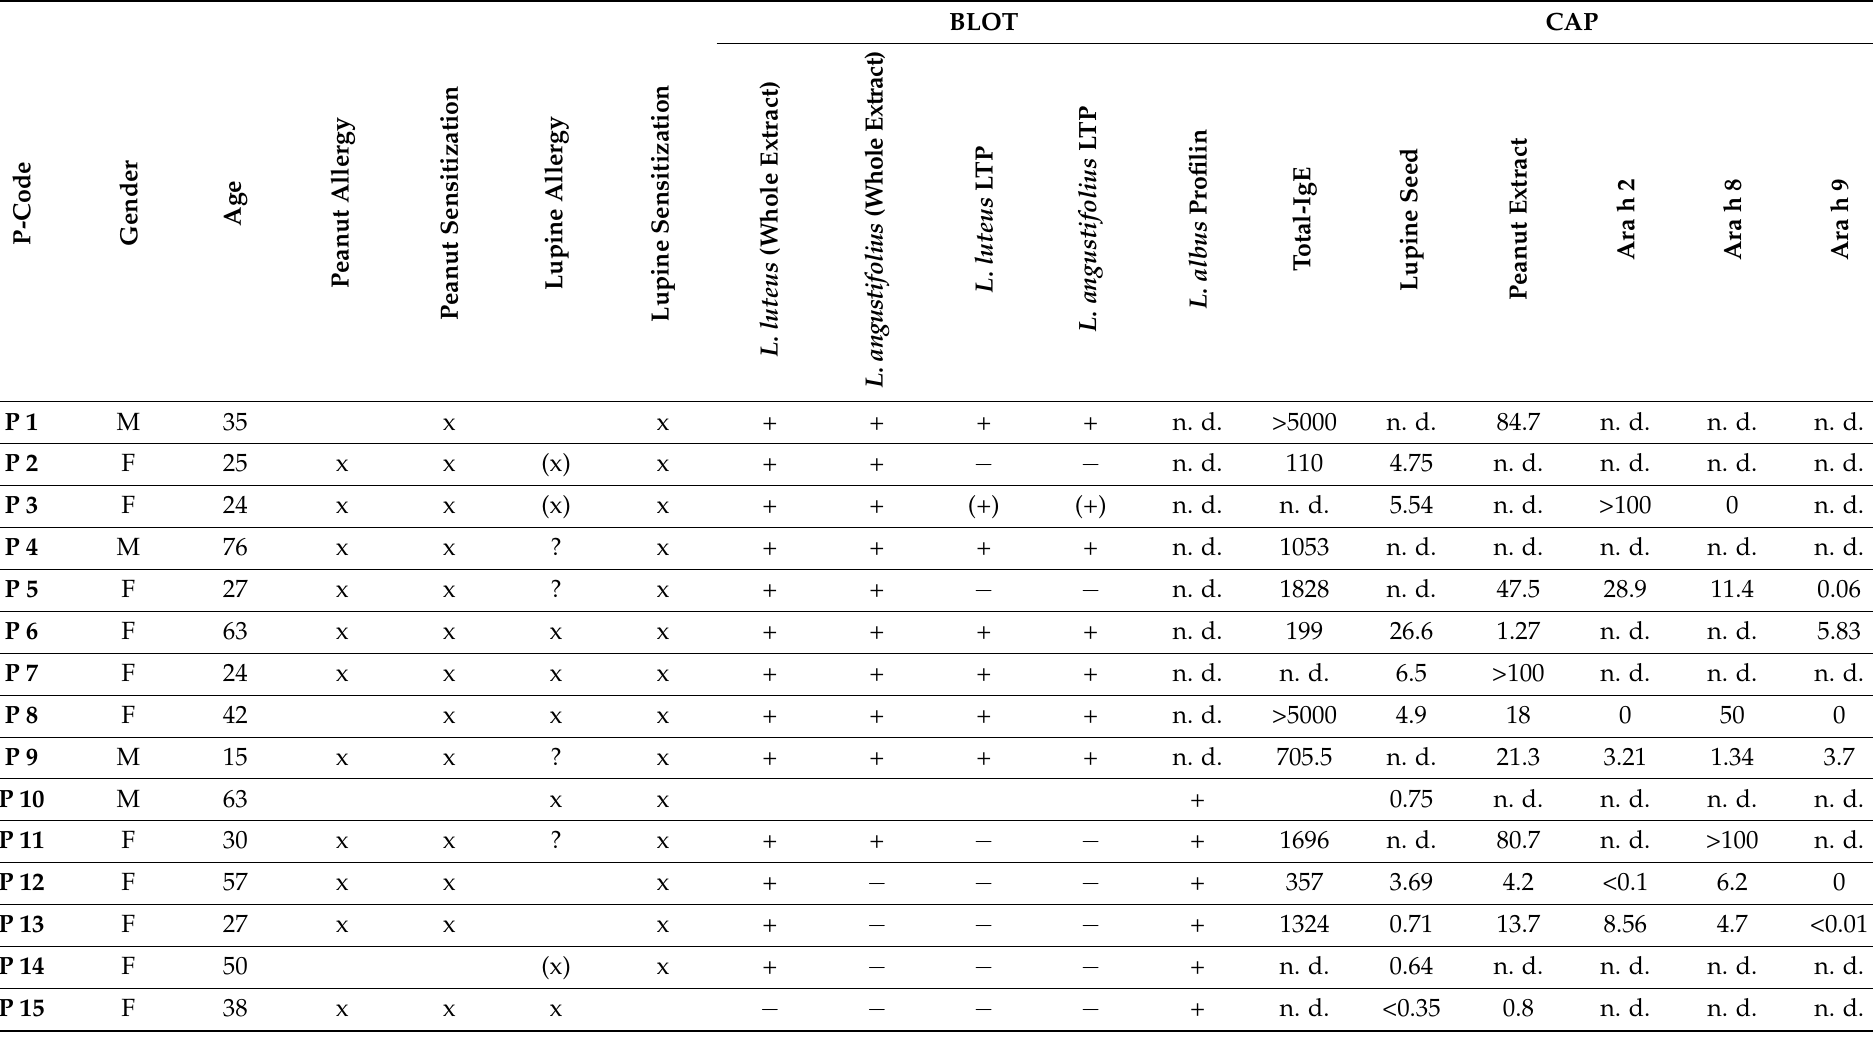
Table 1. Characterization of the patients investigated for IgE-reactivity with lupine extracts and new single